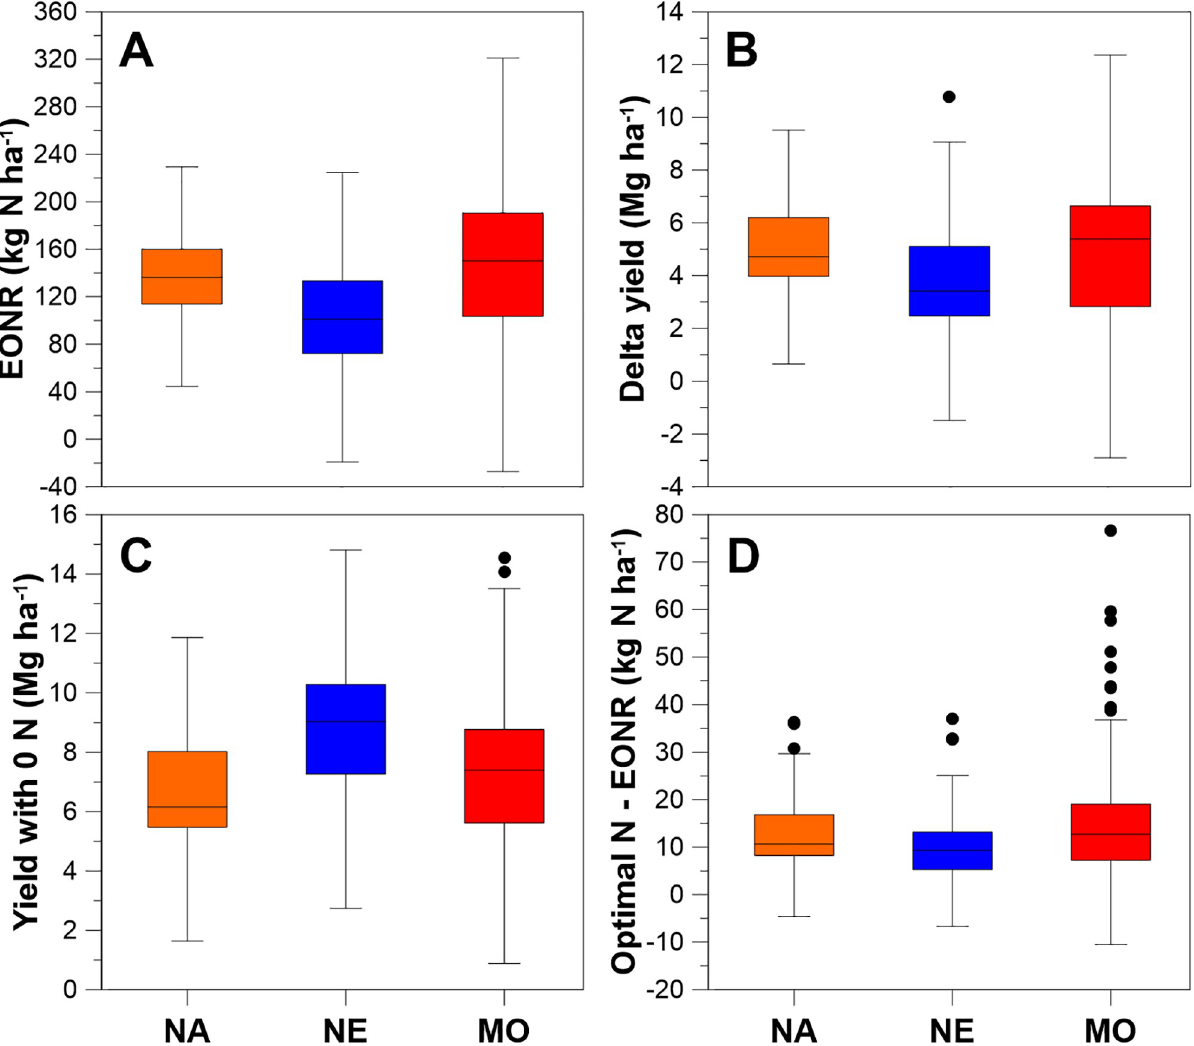
Fig 1. Maize productivity is highly dependent on nitrogen fertilization. Contrasted across the three datasets: (A) EONR, (B) yield increase or delta yield from EONR fertilization, (C) yield without nitrogen fertilization, and (D) the difference between optimal nitrogen rate and EONR. Box limits indicate the first and third quartile, whiskers indicate 1.5 times the interquartile range, points indicate outliers, and box line is the